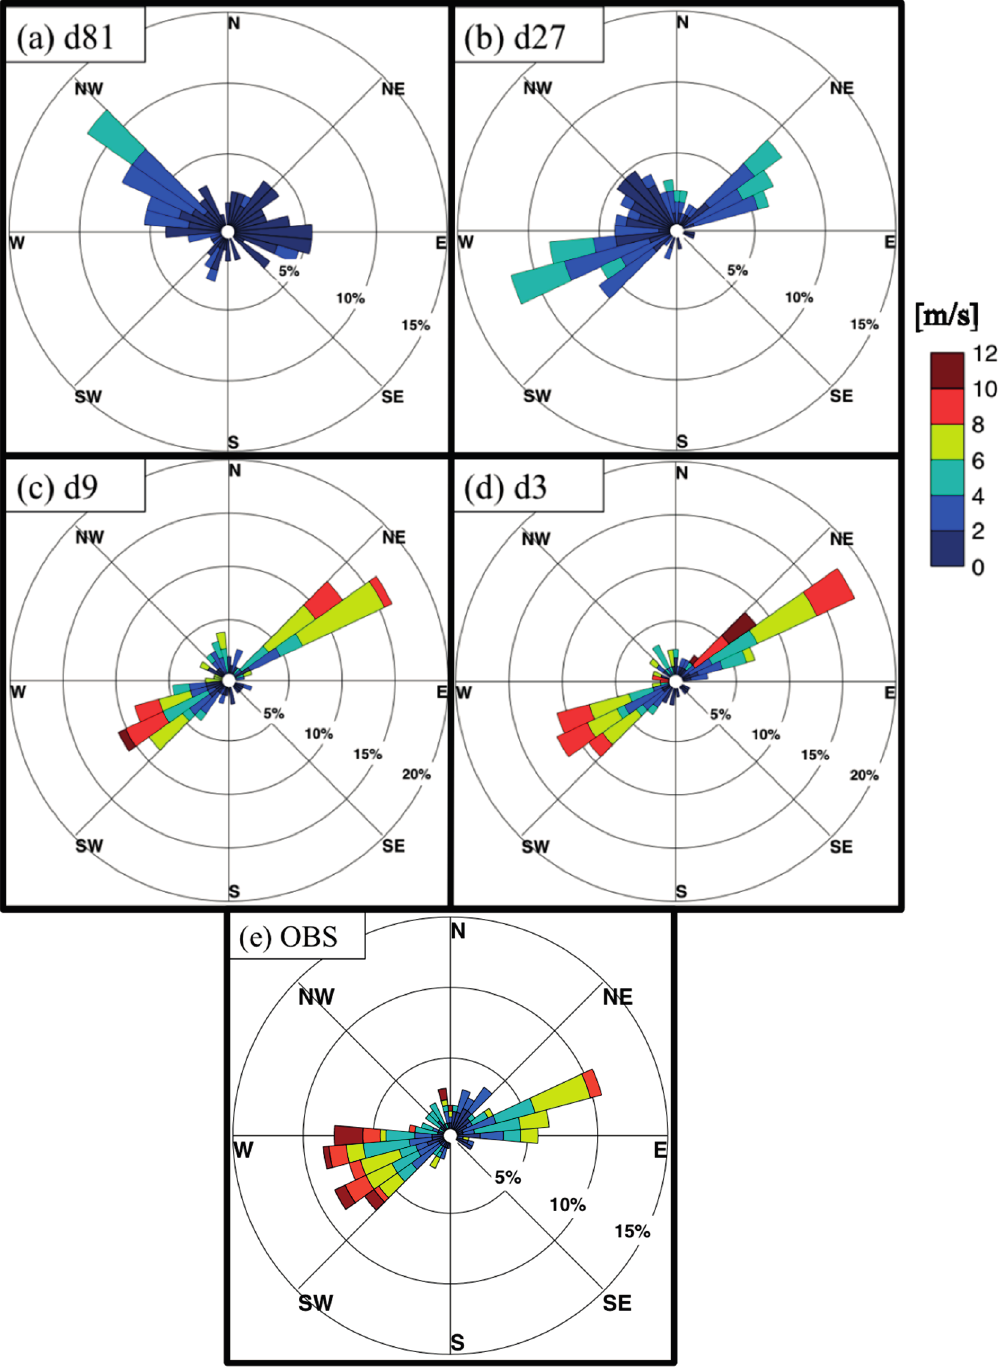
Figure 5. Wind rose diagrams of the low-level horizontal wind for the ( a ) d81, ( b ) d27, ( c ) d9 and ( d ) d3 simulations, averaged over the period from 0000 UTC 4 February to 0000 UTC 7 March 2002, at the grid point closest to Québec City (blue dot in Figure 1); ( e ) Surface wind roses diagrams of the Jean-Lesage Airport surface (© [76]) station averaged over the same period. The colors represent the wind intensities (m/s) and the circles the frequencies (%) for each intensity/direction